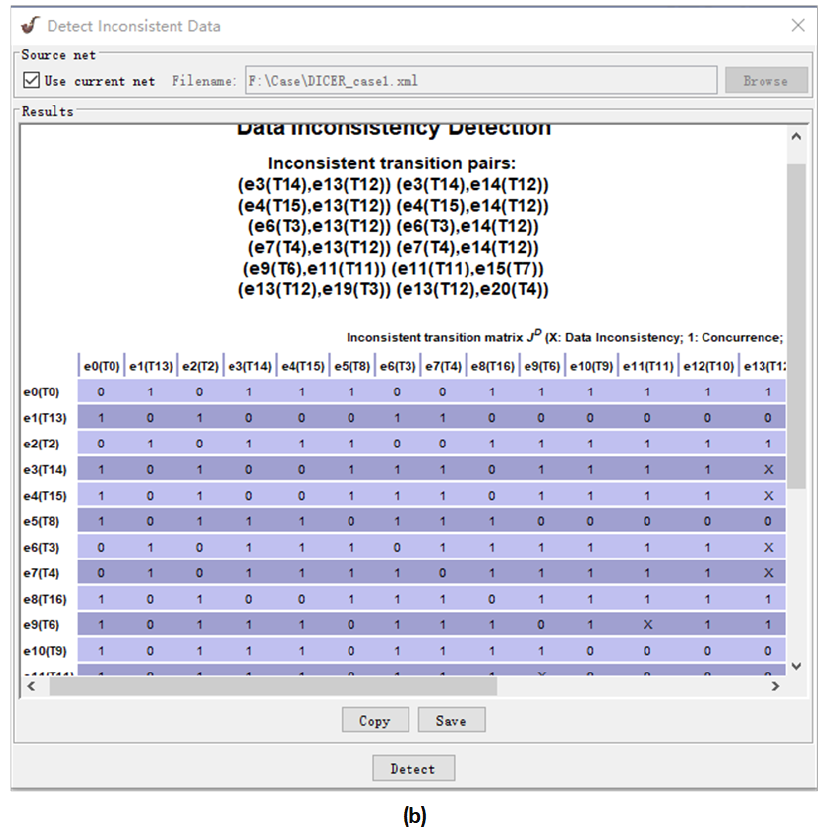
Figure 12. Detecting errors of data inconsistency based on the unfolding techniques of PD-nets; ( a ) an FCP of the PD-net in Figure 11; ( b ) the detection results.